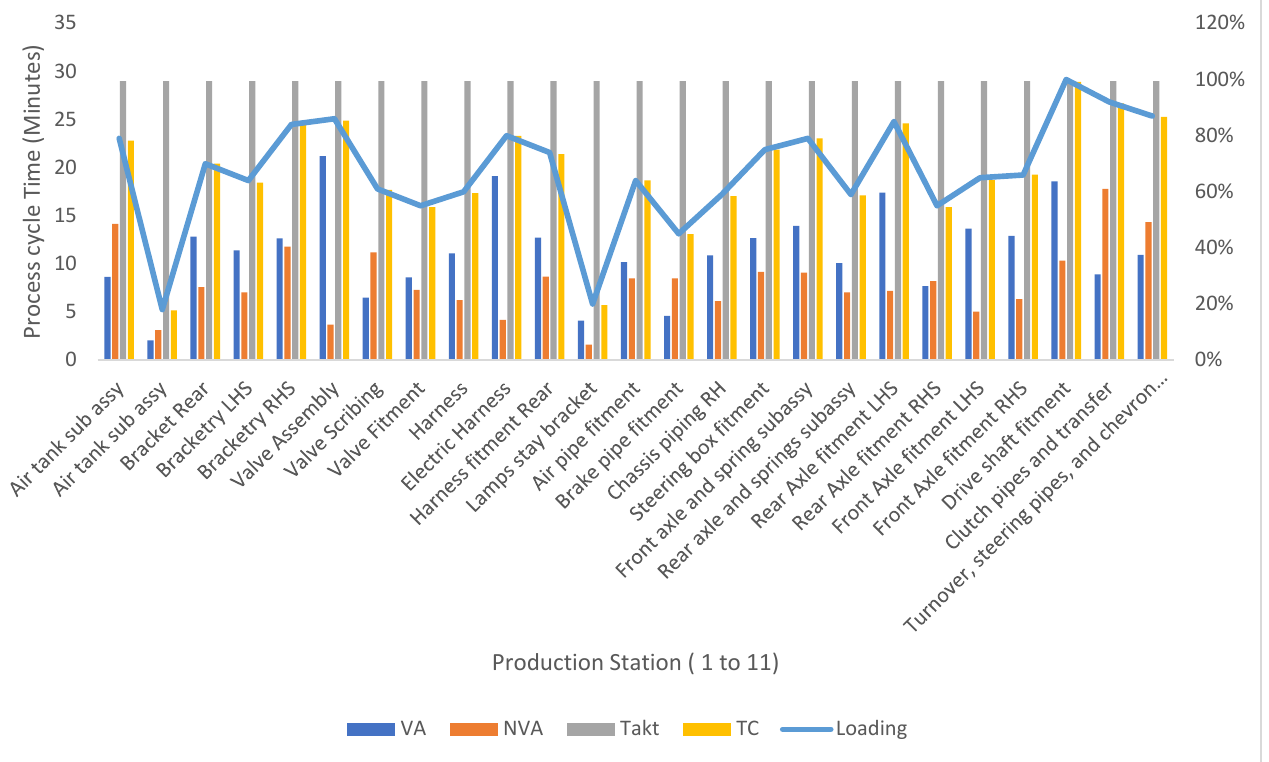
Figure 5. Production station against production cycle time (VA – value added times; NVA – Non- value-added times; Takt time-metric for production time determination).